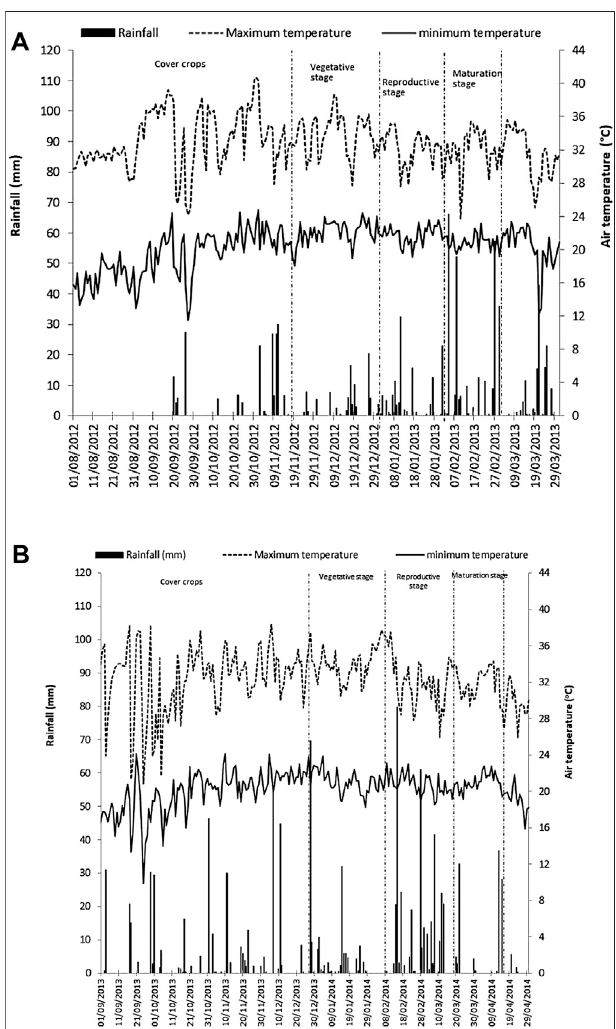
FIGURE 1 | Rainfall (mm), maximum and minimum temperatures ( o C) duringthericegrowingperiodof2012/2013 (A) and2013/2014 (B) inSelvíria, MS,